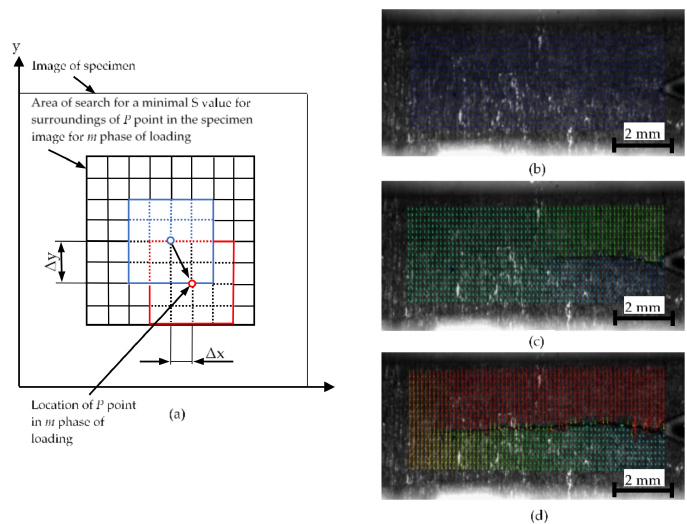
Figure 4. Analysis of the specimen image with the use of a digital correlation: ( a ) scheme of operation; ( b – d ) particular stages of the crack